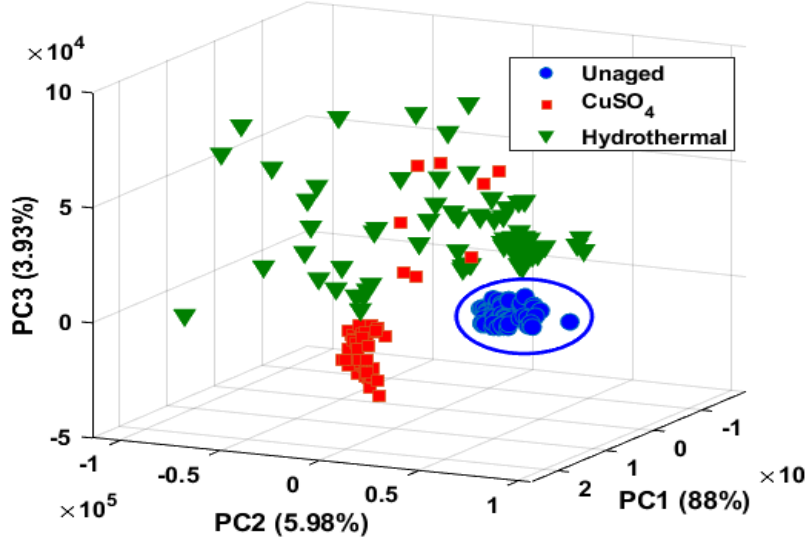
Figure 12. PCA score plot of test specimens classified with respect to the aging studies.